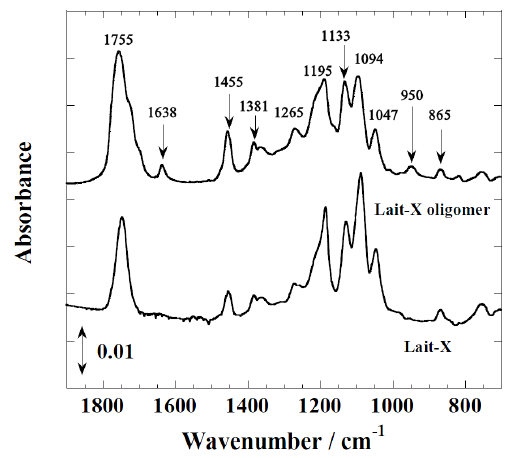
Figure 1. FTIR spectra of Lait-X bulk and Lait-X oligomers.